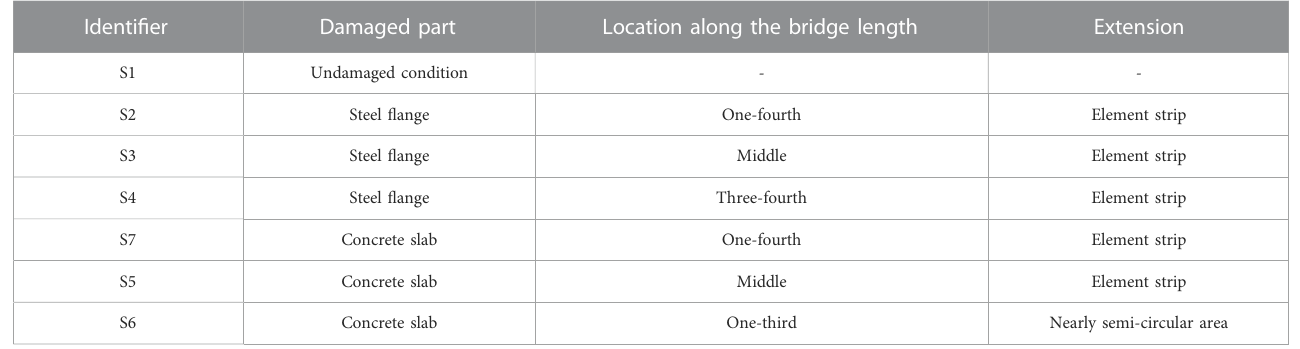
TABLE 2 Numerical case study: description of the damage scenarios of model R. Identi fi